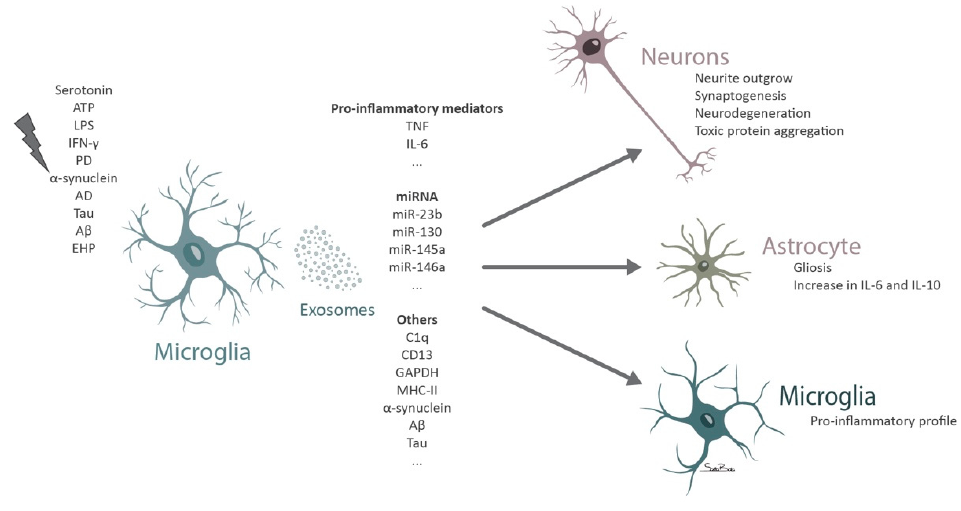
Figure 3. Diagram depicting the contribution of microglial exosomes to neurodegeneration. Under physiological conditions the release of serotonin by neurons induces the re- lease of exosomes by microglial cells through the activation of 5-HT2a,b and 5-HT4